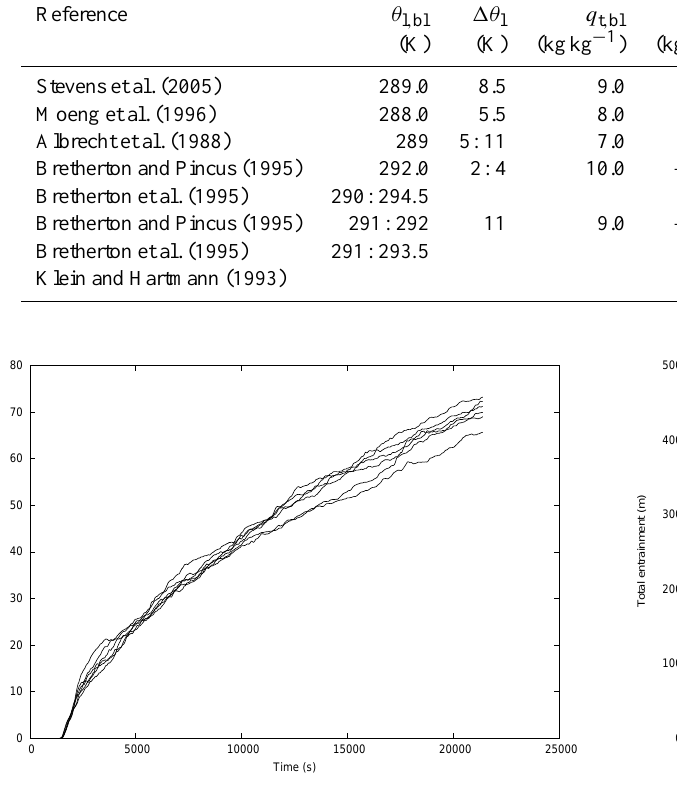
Fig. 4. Total entrainment against simulated time for six executions of the wrapped ERM differing only in a 0.0025K perturbation to the high-resolution start state.